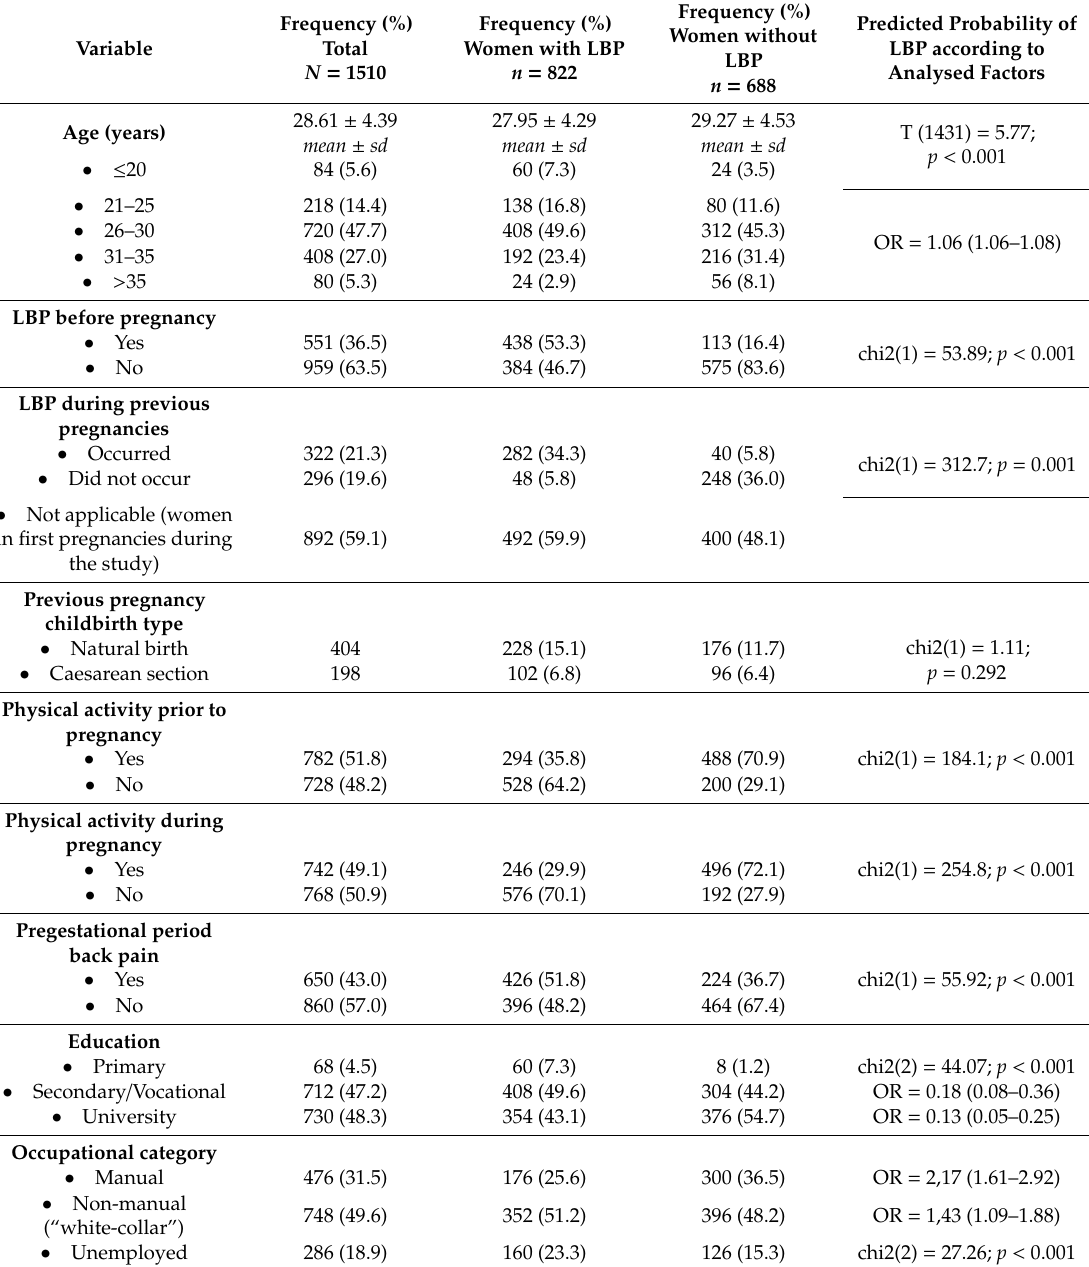
Table 2. LBP risk factors in pregnant